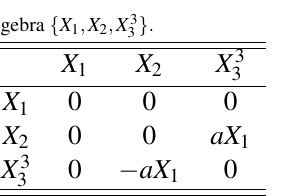
Table 5: Commutator table for the Lie algebra { X 1 , X 2 , X 3